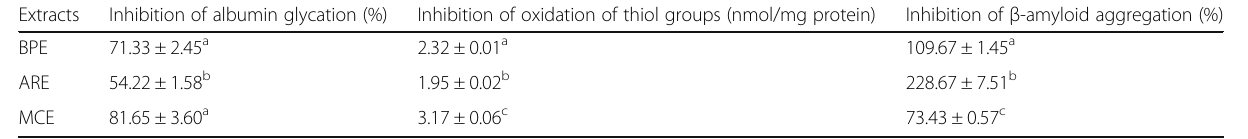
Table 4 Antiglycation properties of the aqueous extracts of dried leaves of C. alata Extracts Inhibition of albumin glycation (%) Inhibition of oxidation of thiol groups (nmol/mg protein) Inhibition of β -amyloid aggregation